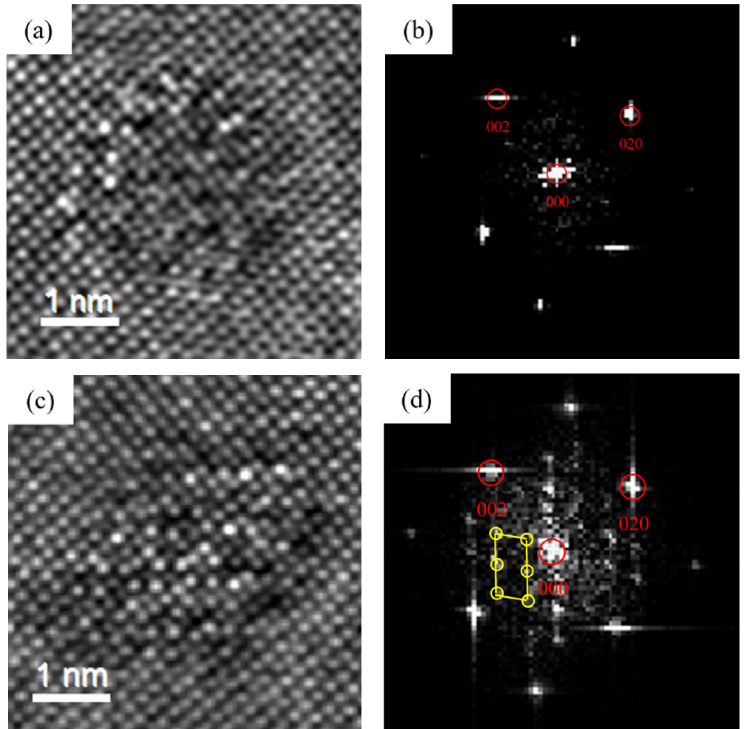
Figure 5. HRTEM and fast Fourier transform (FFT) patterns of precipitates of 0Cu alloy after initial aging at 175 °C for 0.5 h. ( a , b ) GP zones; ( c , d ) pre- β″ .